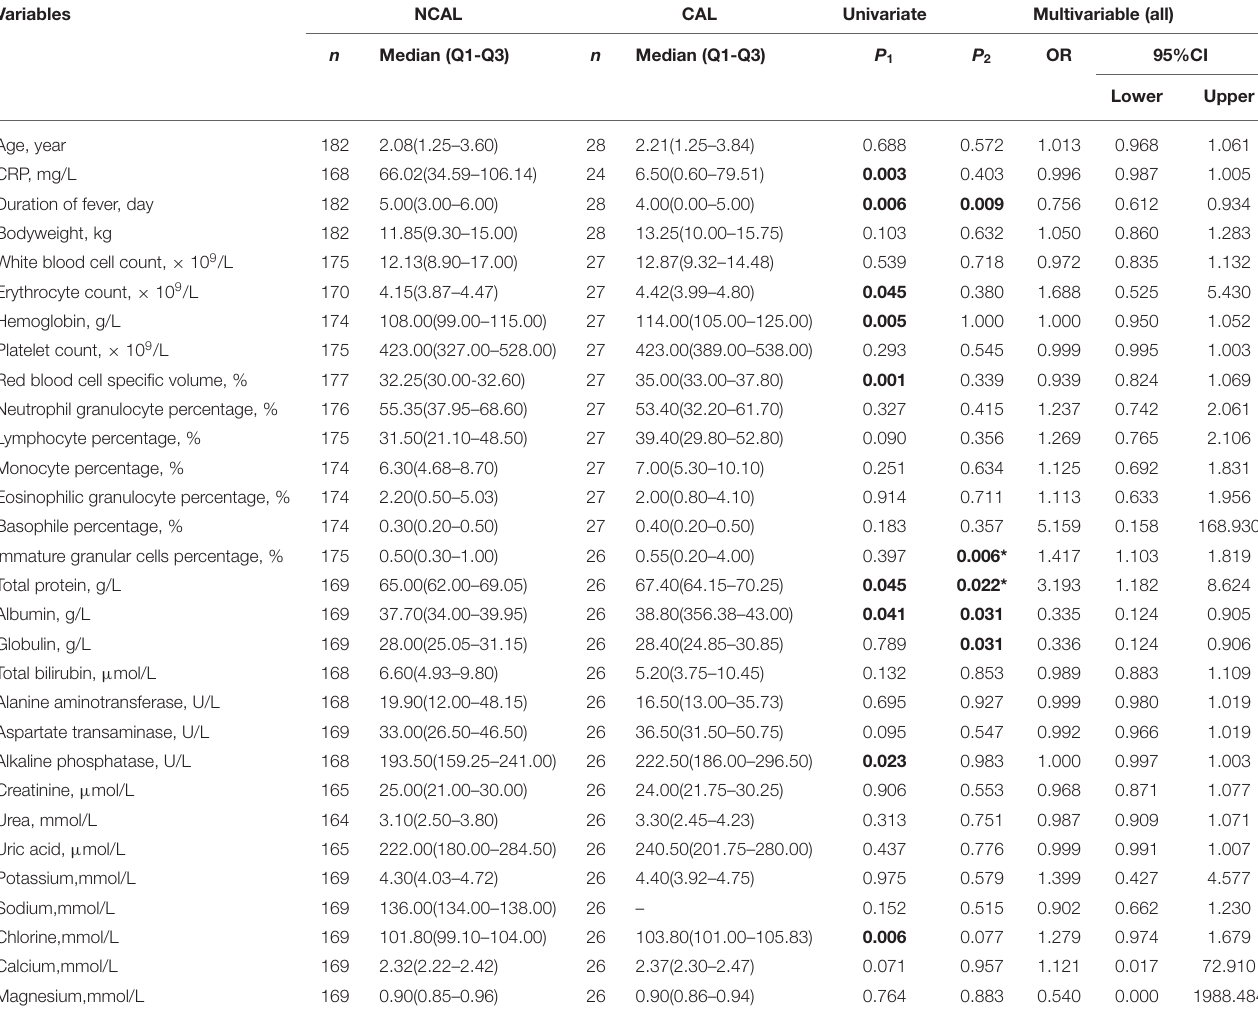
TABLE 2 | Comparison of groups with and without coronary artery lesions before the use of antibiotics.